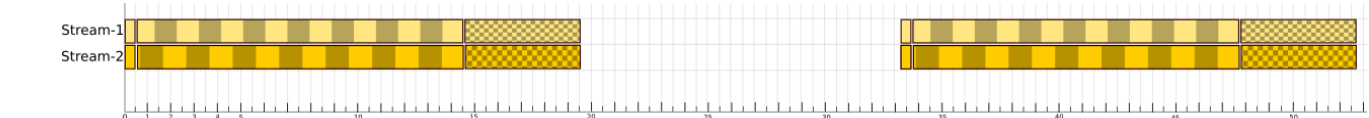
Figure 12. Stream processing schedule using CPU